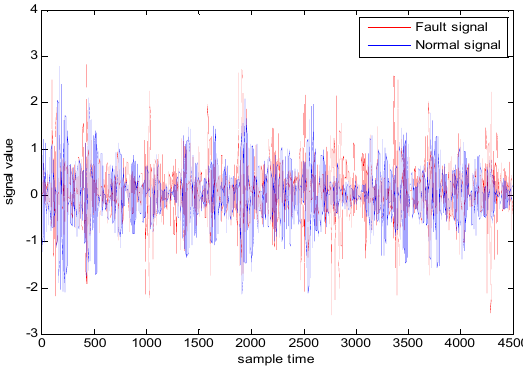
Figure 4. Normal and fault data in the time domain.